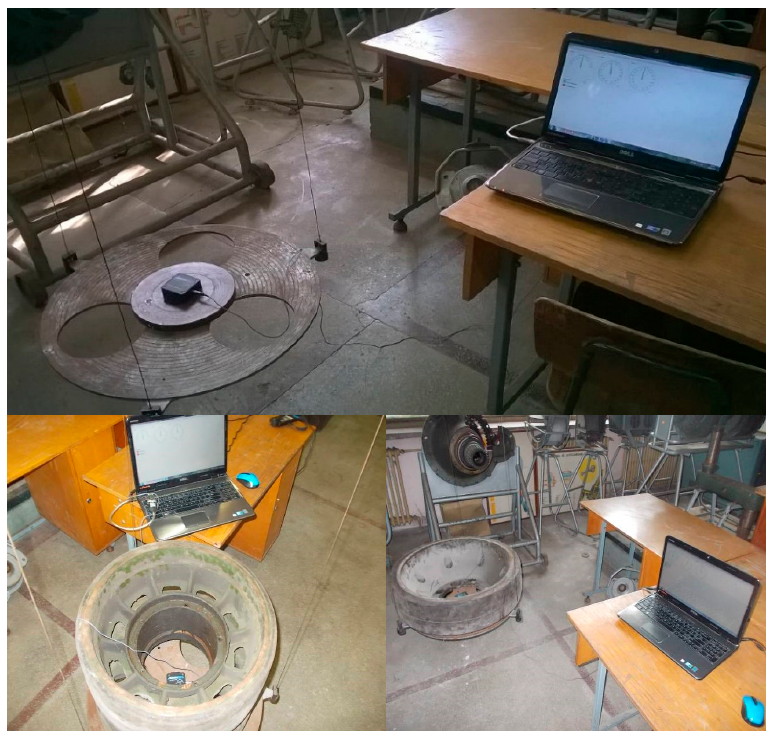
Figure 25. Representation of the experimental procedure for determining moments of inertia.